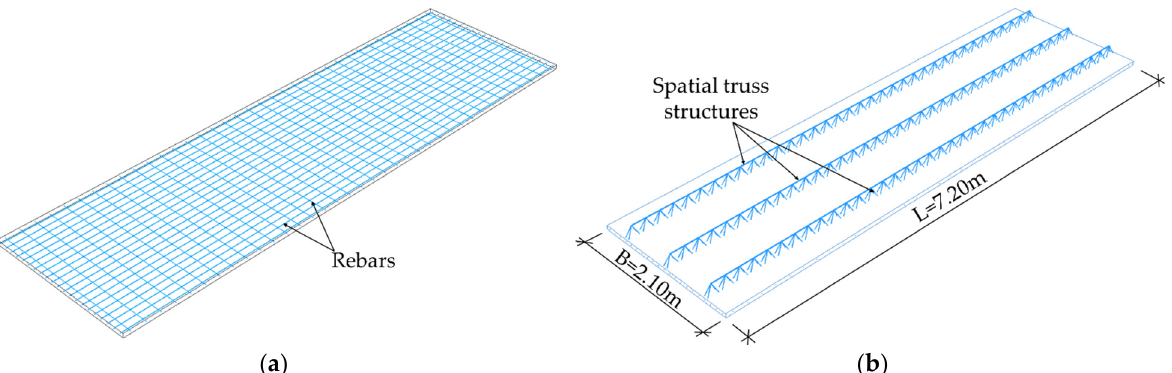
Figure 5. Filigree ceiling slab with D-type trusses ( a ) rebars; ( b ) concrete